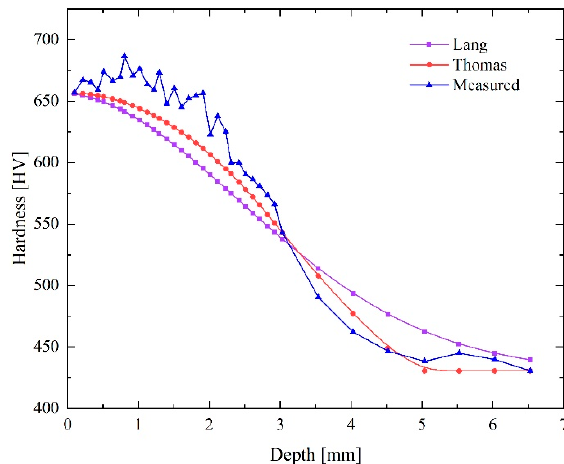
Figure 6. Gear hardness test.